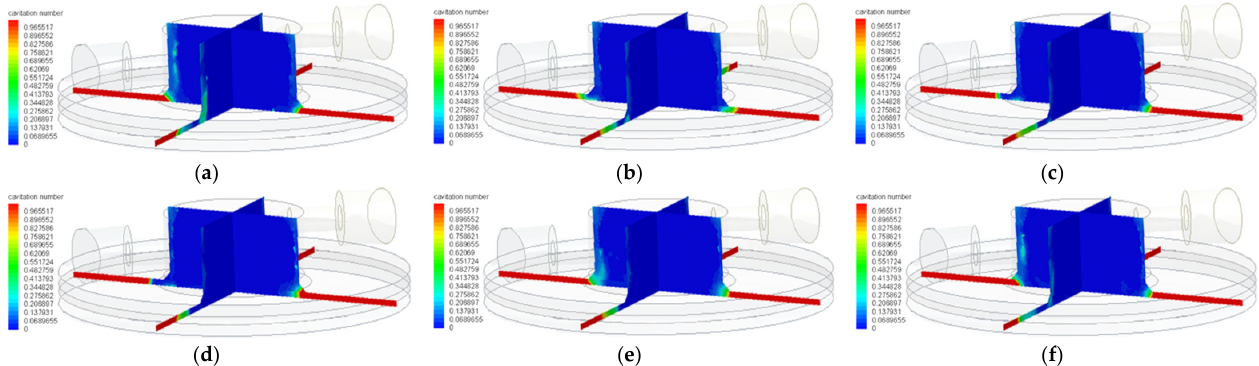
Figure 17. When inlet pressure = 15 MPa, gap = 1.5 mm, the variation of cavitation number of the original suction cup with time in vertical axial cross planes at: ( a ) 5 ms, ( b ) 9.4 ms, ( c ) 13.8 ms, ( d ) 18.2 ms, ( e ) 22.6 ms, and ( f ) 27 ms.